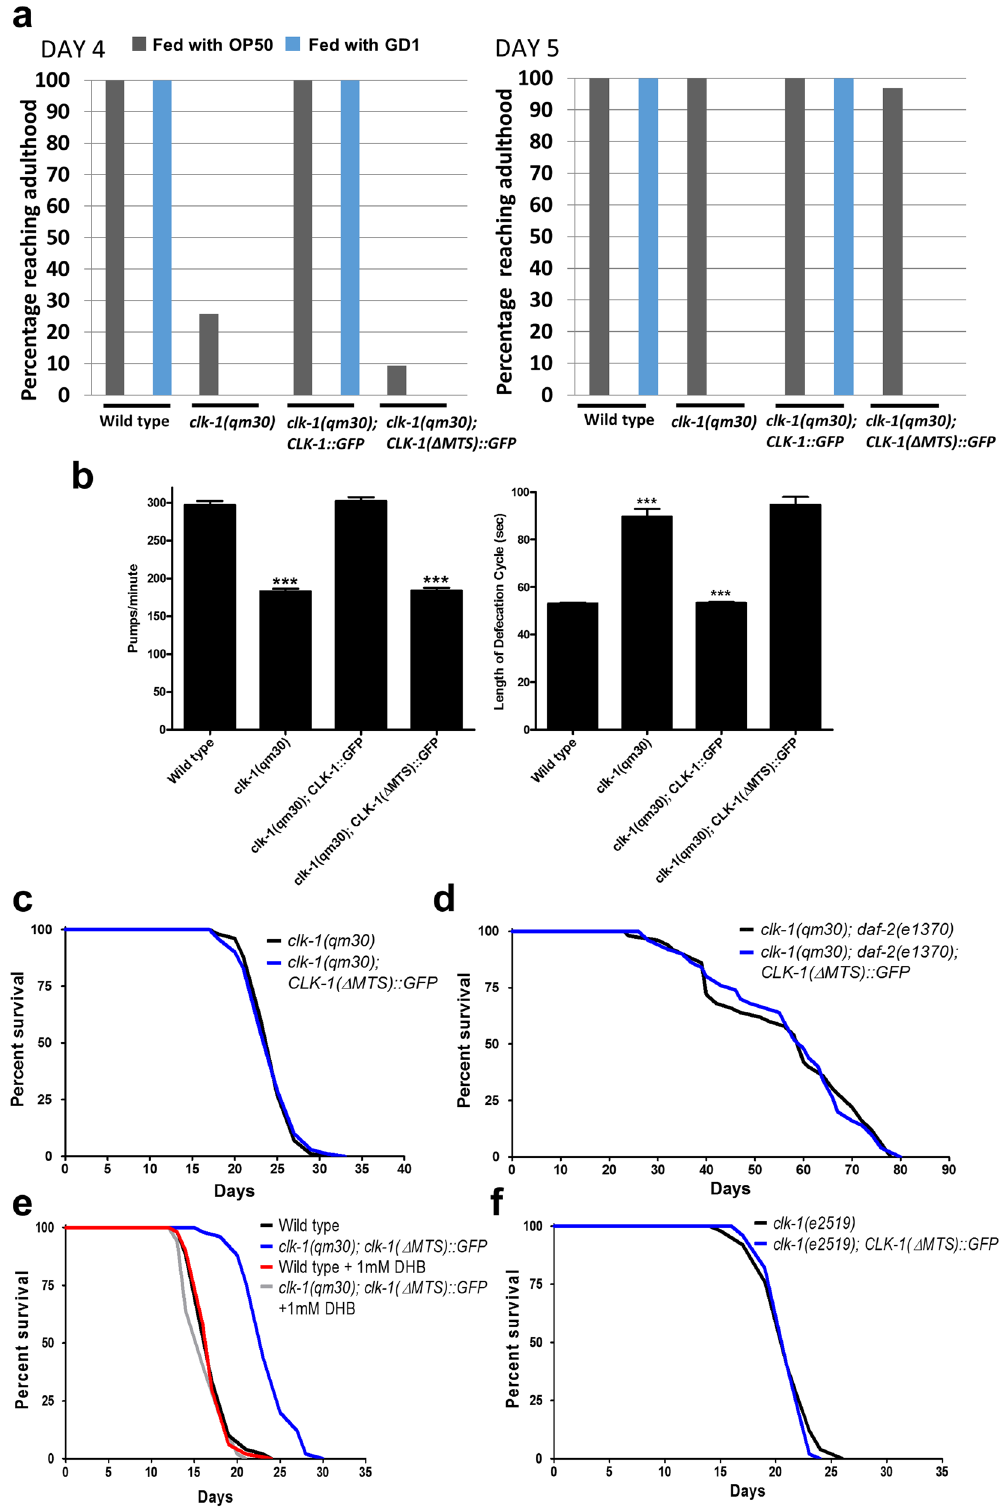
Figure 5. CLK-1 ( Δ MTS ):: GFP cannot rescue the phenotypes of clk-1 mutants ( a ) clk-1 ( qm30 ) mutants grow slowly when fed OP50 and arrest when fed UQ 8 -deficient bacteria GD1. Both phenotypes are rescued by a single copy insertion of full length CLK-1::GFP. Neither phenotype is rescued by a single copy insertion of CLK- 1 ( Δ MTS ):: GFP , which lacks the mitochondrial targeting sequence of clk-1 . (n ≥ 30 animals for each genotype). ( b ) The slow pumping rate and slow defecation of clk-1 ( qm30 ) mutants can be fully rescued by the expression of full length CLK-1::GFP but not by the expression of CLK-1( Δ MTS)::GFP. Bars represent the mean number of pumps per minute or the mean defecation cycle of animals that have been scored for three consecutive defecation cycles each in the case of clk-1 ( qm30 ) mutants and for five consecutive defecation cycles for all